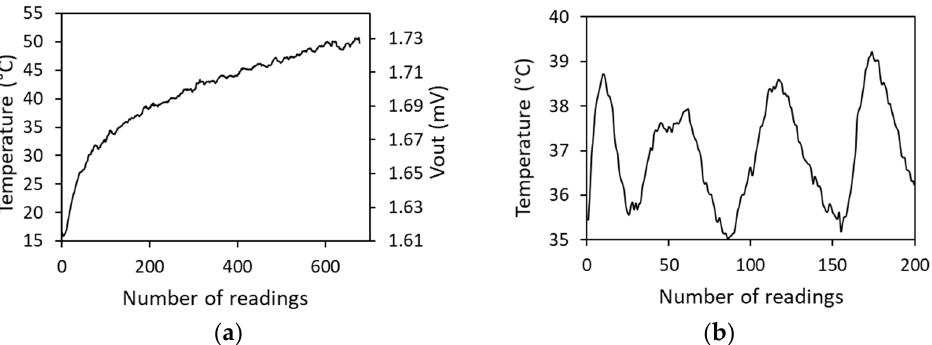
Figure 12. ( a ) Microsensor response with implemented electronics to temperature variation from 15 to 50 °C. ( b ) Dynamic test.